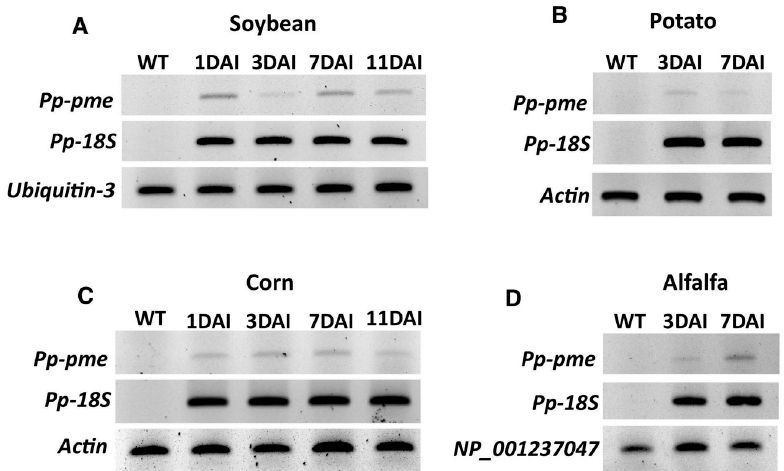
Fig 6. Semi-quantitative RT-PCR showing the transcript levels of Pp-pme in different host plants at different time points after infection. Total RNA extracted from nematode infected roots of economically important host plants (A) soybean, (B) potato, (C) corn, and (D) alfalfa was used to validate the relative expression of Pp-pme at different days after nematode infection (DAI). The nematode 18S rDNA gene was used as internal control to validate the presence of P . penetrans within the infected roots, while specific plant reference genes were used for each specific host plant. Wild- type (WT) correspond to non-infected plants.